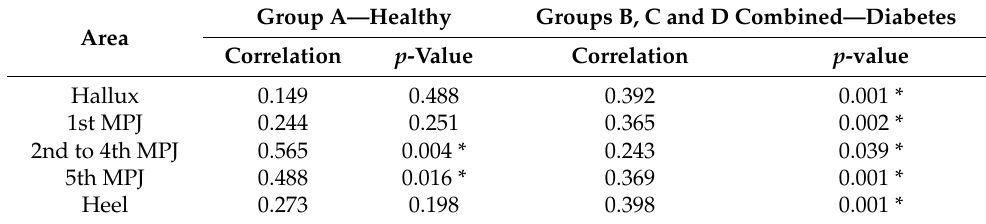
Table 3. Pearson correlation test of Groups A vs. Groups B, C and D. Group A—Healthy Groups B, C and D Combined—Diabetes Area Correlation p -Value Correlation p -value Hallux 0.149